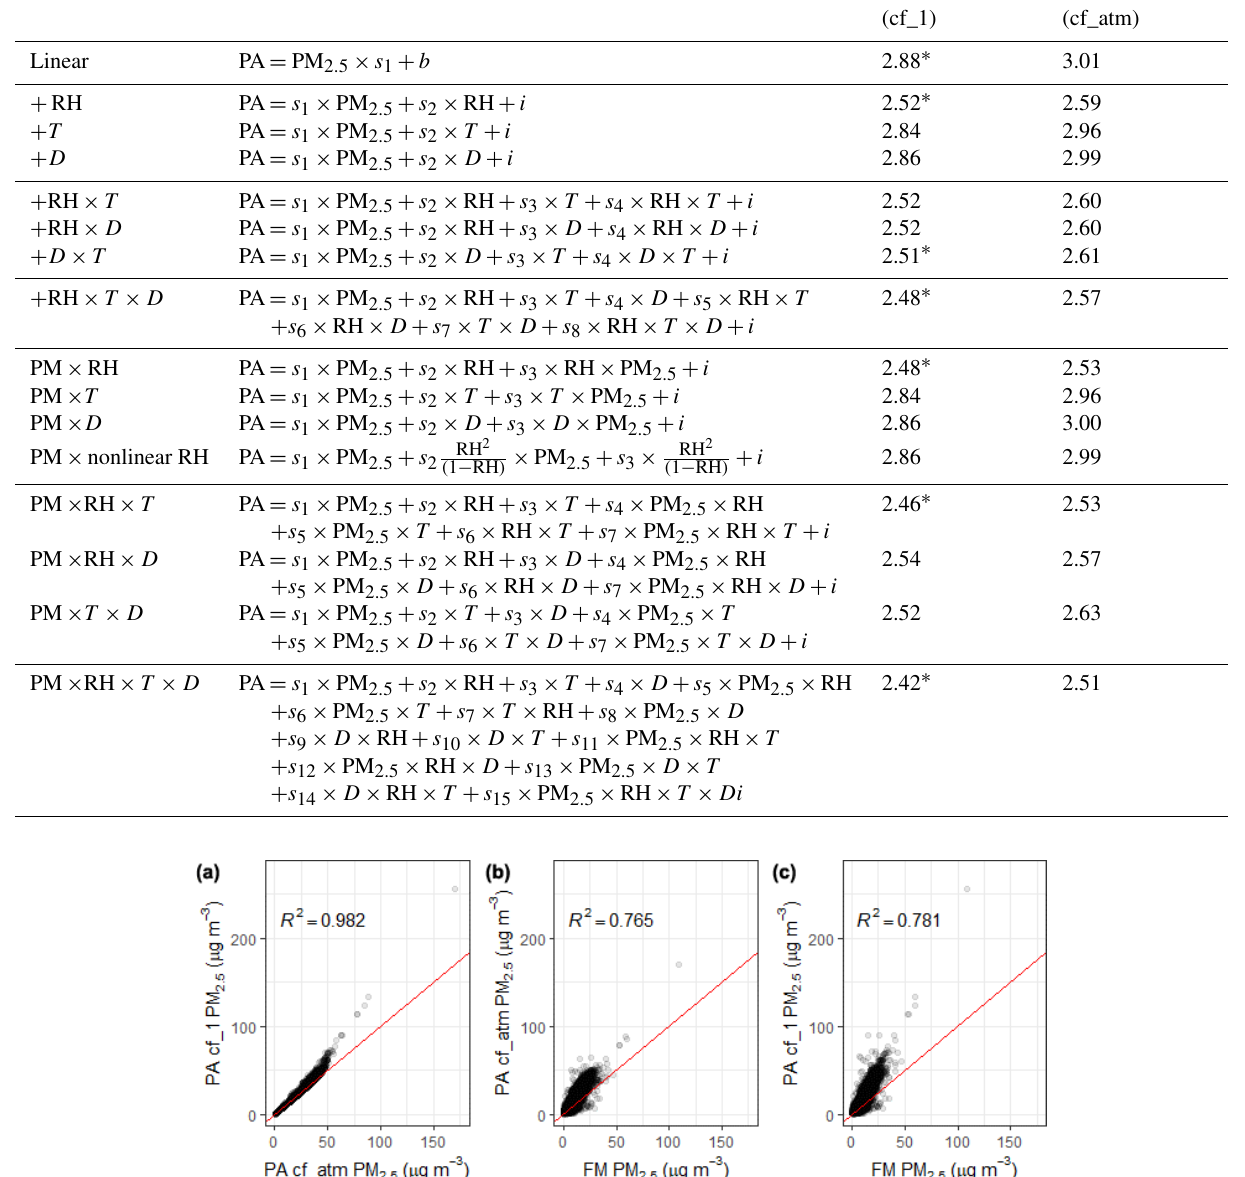
sidered (Table 2, rows 6–9). Lower error was observed for the + D × T (RMSE = 2.51 µg m − 3 ) compared to other models of similar complexity, and slightly lower error was observed when adding RH as well ( + RH × T × D RMSE = 2.48 µg m − 3 ). Adding interaction terms